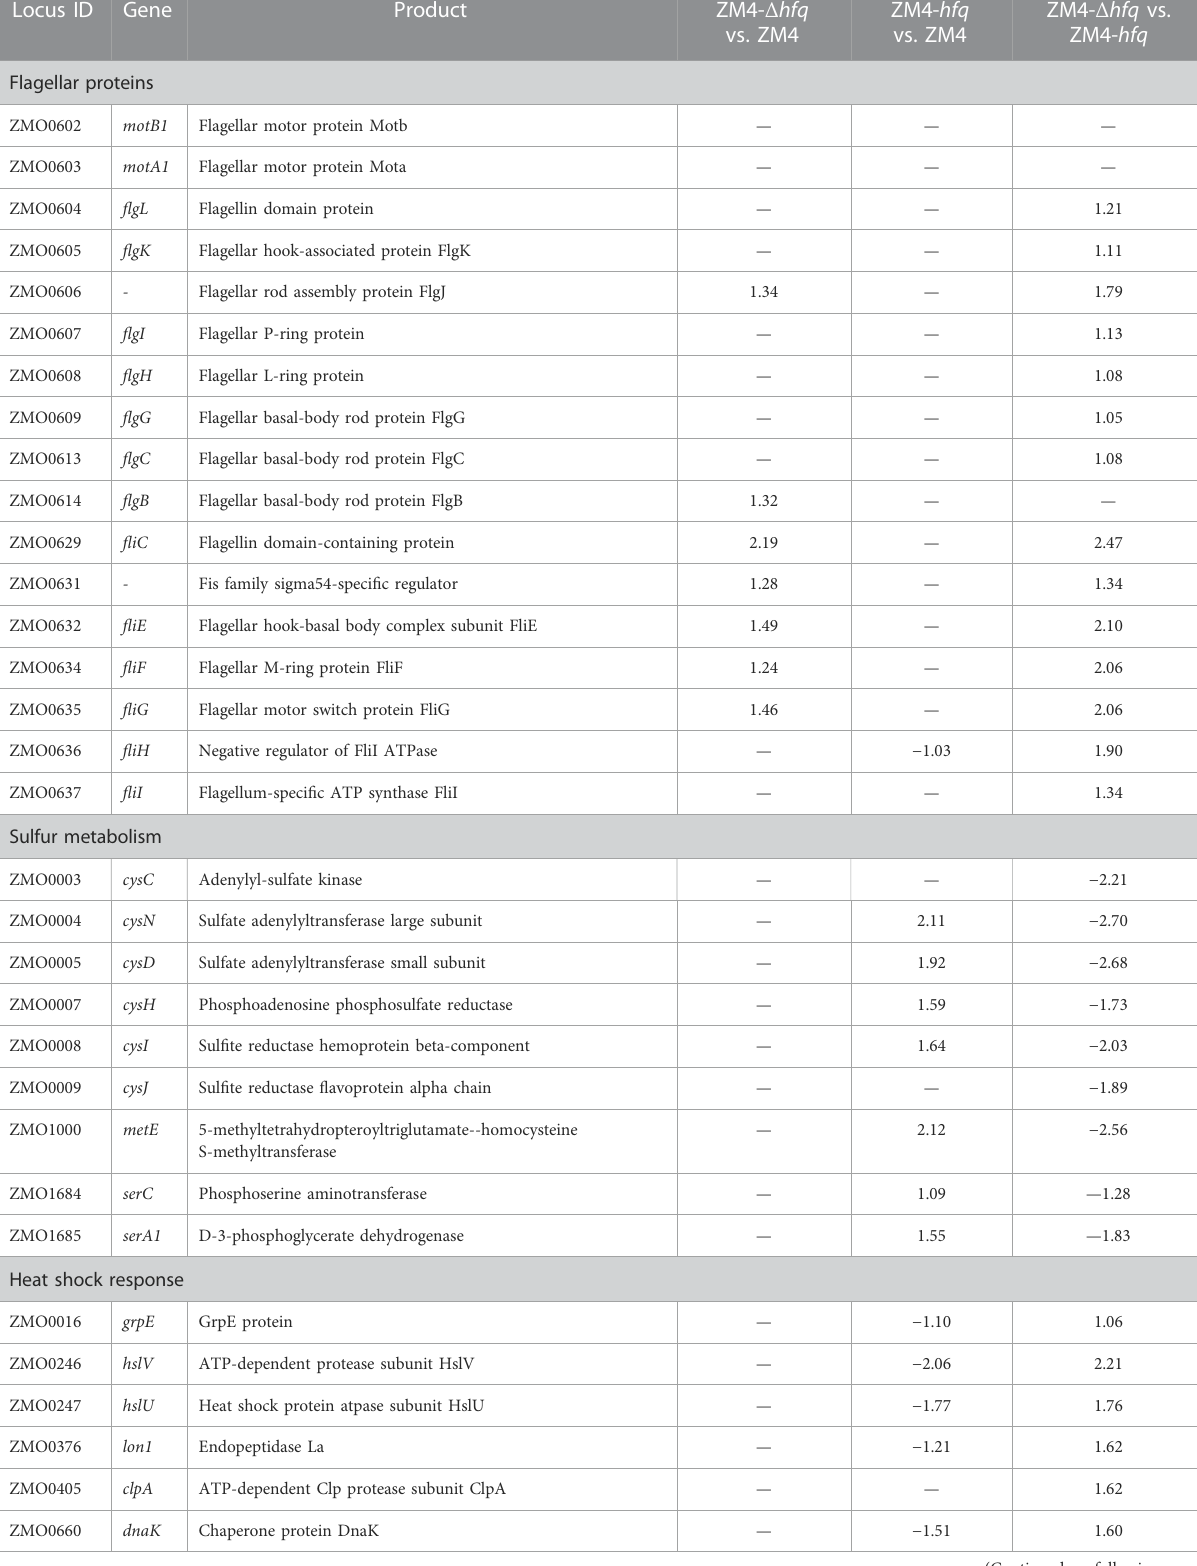
TABLE 1 List of signi fi cantly differentially expressed genes in different functional categories between strain comparisons under 8% (v/v) ethanol treatment. Locus